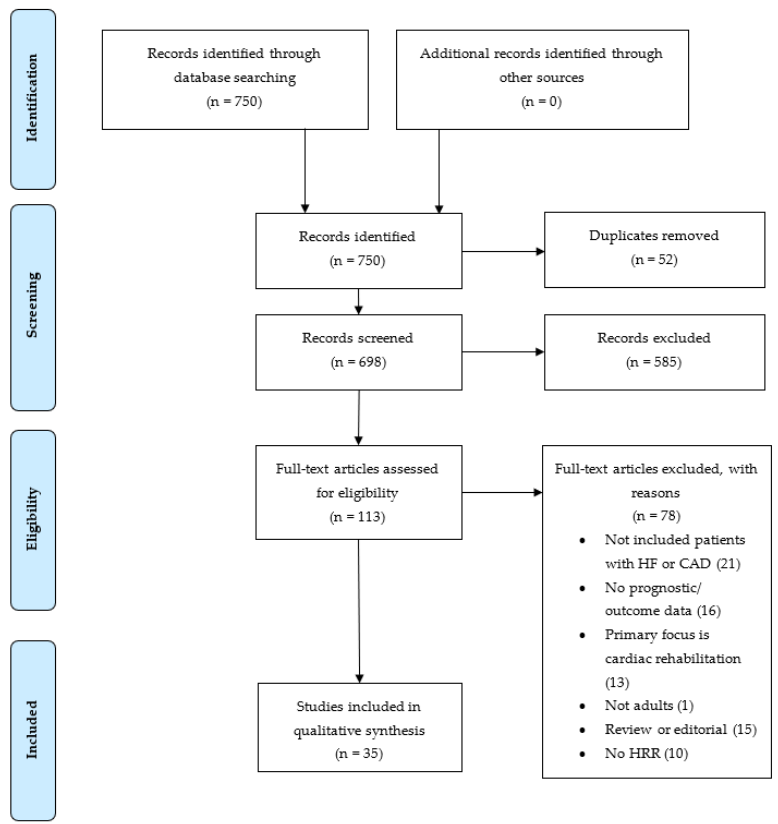
Figure 1. Study selection flow diagram showing number of records identified, screened, excluded, and included as part of the final review. HF = heart failure, CAD = coronary artery disease, HRR = heart rate recovery.